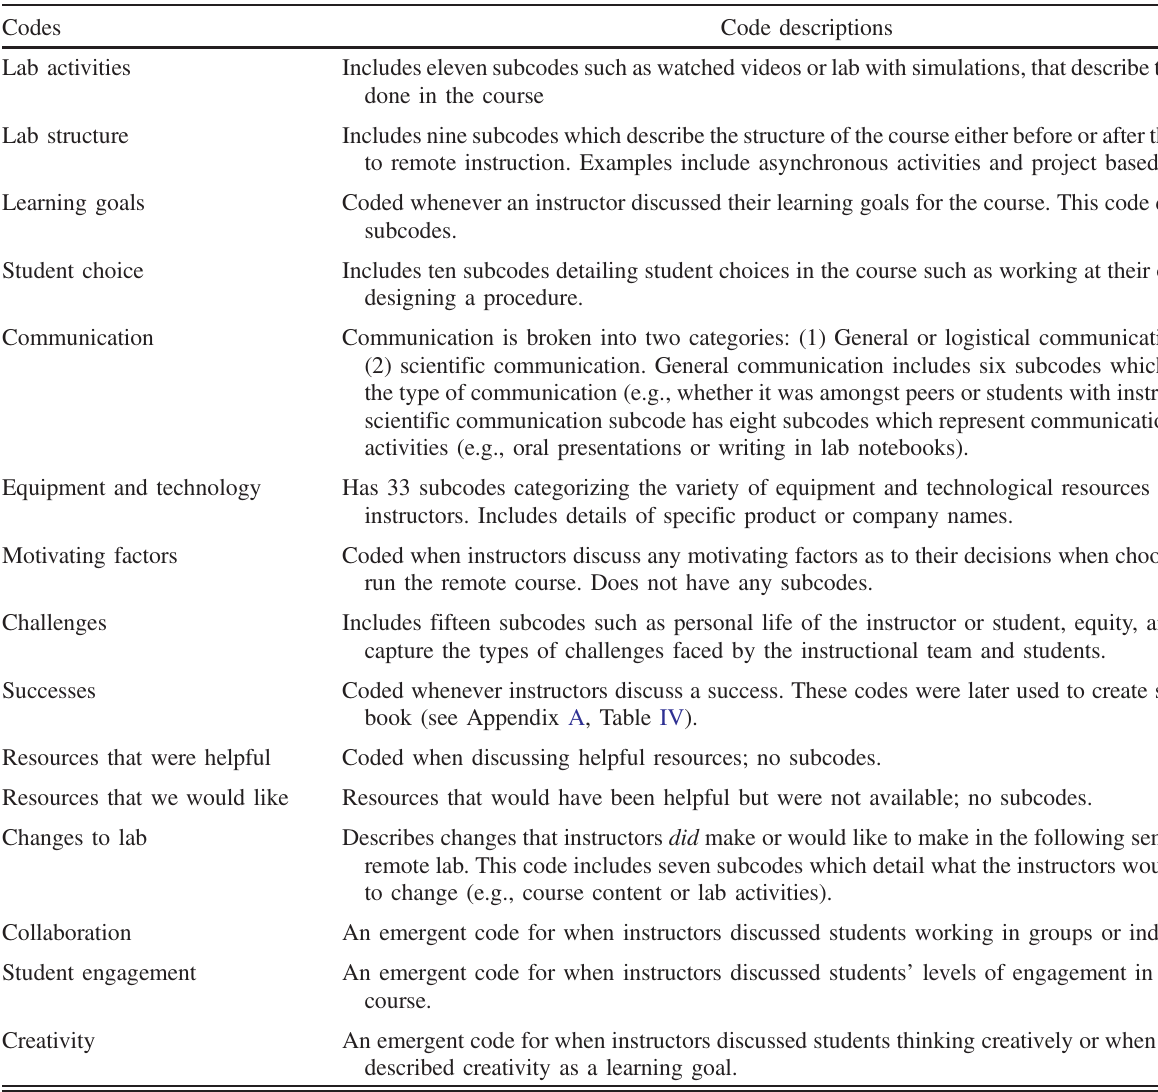
TABLE III. Description of major codes in first code book.